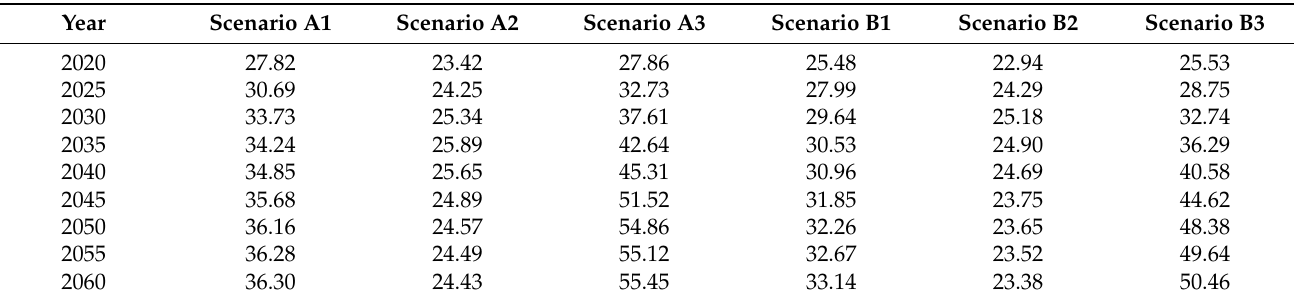
Table 12. Projected carbon emissions under different